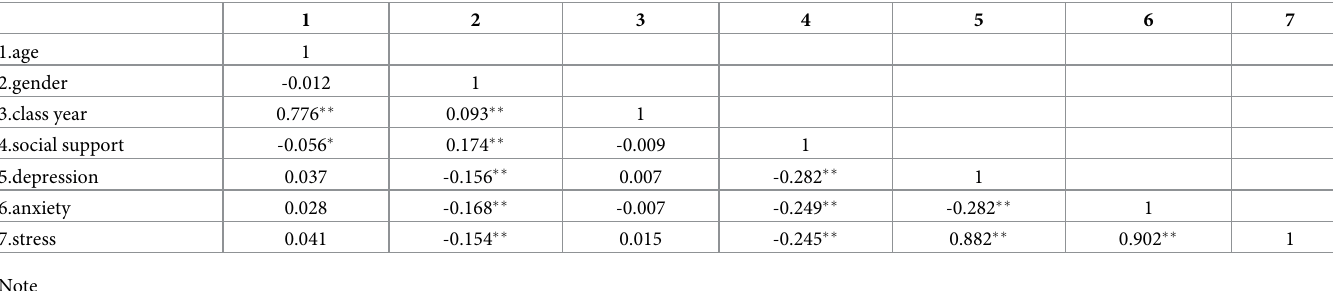
Table 3. Correlation matrix of the factors and mental health condition of undergraduate students. DOI: